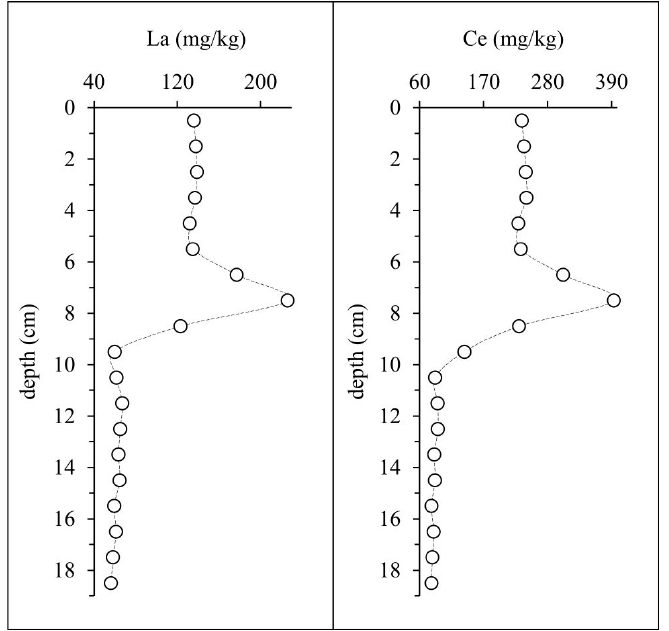
Figure 10. The vertical distribution of La and Ce in sediments of Lake Imandra (Murmansk Region) [38].